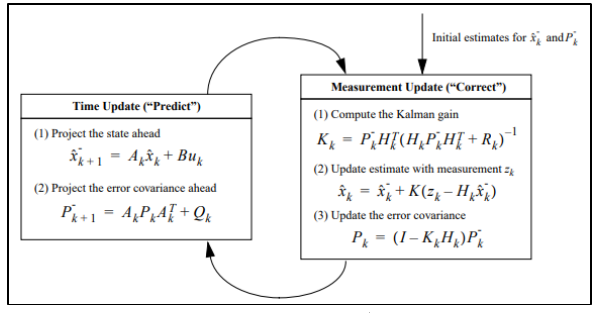
Figure 10. The main concept of KF (Welch G., & Bishop